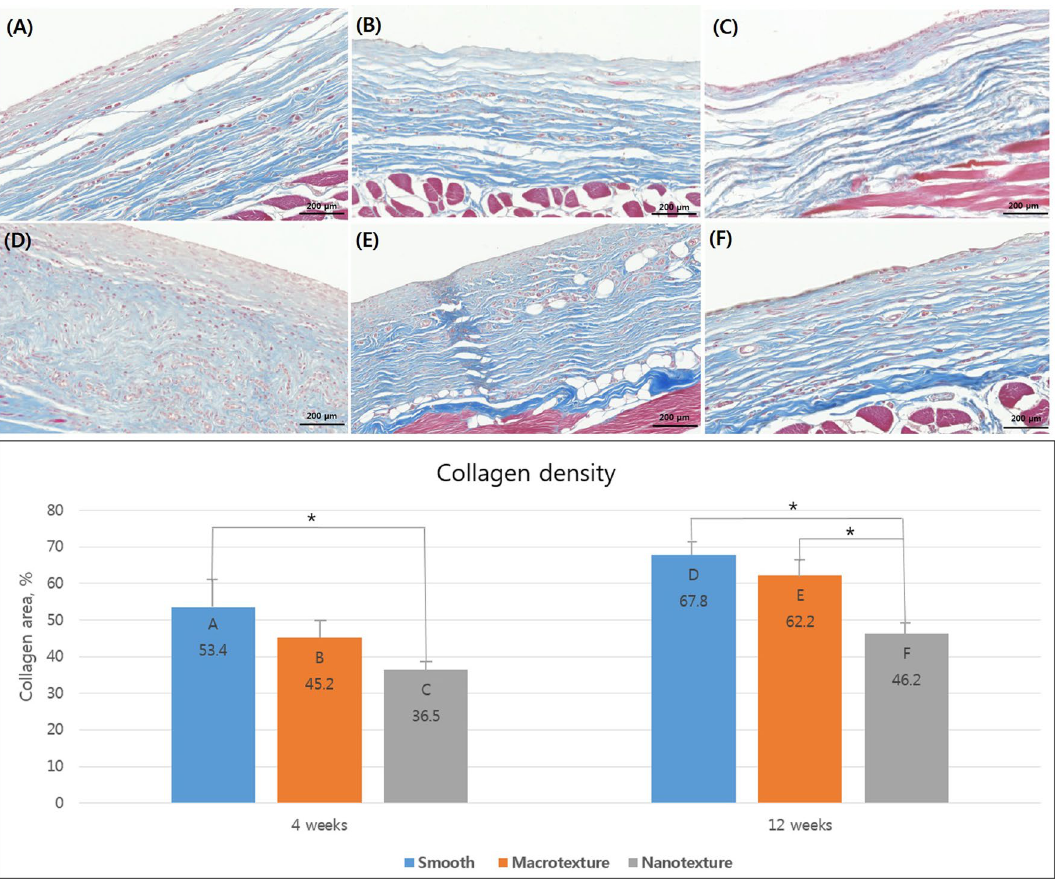
Figure 3. Collagen density and arrangement across the three different types of silicone implants. Representative histologic sections of capsular tissues on the silicone implants showing collagen density and arrangement. Sections were stained with Masson trichrome (original magnification × 100; scale bar = 200 μm). Collagen density measurement according to collagen area. The black asterisks in the bars represent P values indicating significant differences between the groups ( P < 0.05). ( A ) Group A (4 weeks, smooth type), ( B ) Group B (4 weeks, macrotexture type), ( C ) Group C (4 weeks, nanotexture type), ( D ) Group D (12 weeks, smooth